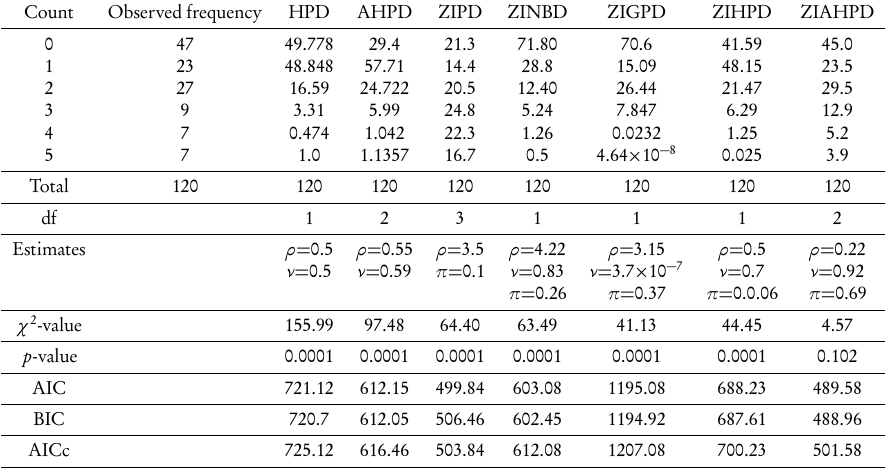
Distribution of data of Corn borers per hill (Rodriguez-Avi et al. , 2007) and the expected frequencies computed using hyper-Poisson, alternative hyper-Poisson, zero-inflated Poisson, zero-inflated negative binomial, zero-inflated generalized Poisson, zero-inflated hyper-Poisson and ZIAHPD.